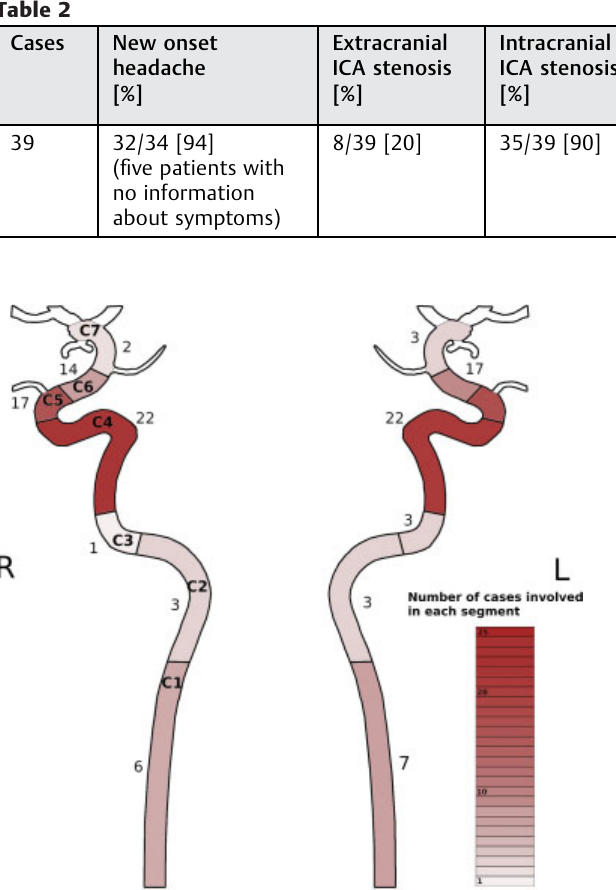
Fig.1 A schematic addition of all cases of ICA (internal carotidartery) involvement. A strong focus on the carotid siphons is apparent.